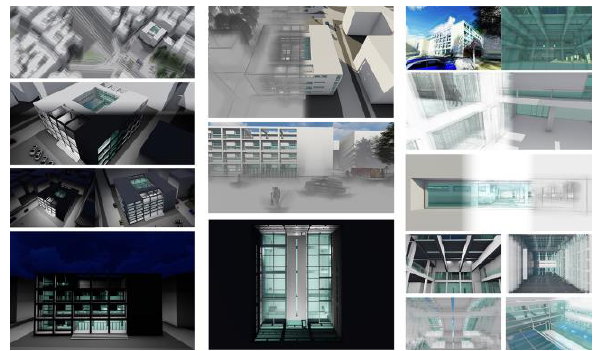
Figure 18 . Casa del Fascio, Terragni (1936). On the top left, decomposition of the line-force, exaltation of dark tones and a widespread illumination. Brera Academy of Fine Arts Milan (A. De Masi).